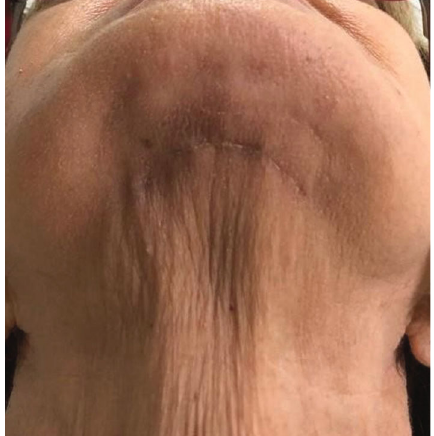
Figure 4: Fixation of the graft.